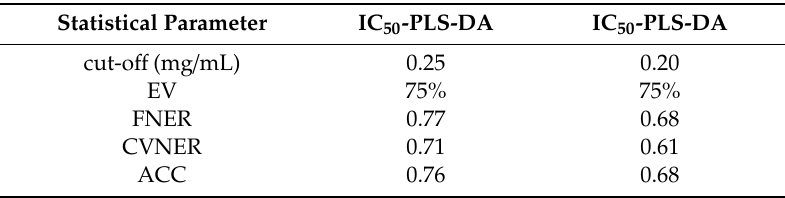
Table 1. Cross-validation scores for the binary partial least squares discriminant analysis (PLS-DA) classification models built with di ff erent IC 50 cut-o ff values.